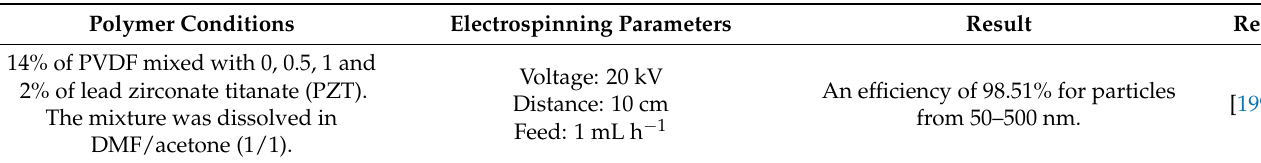
Table 1. Cont. Polymer Conditions Electrospinning